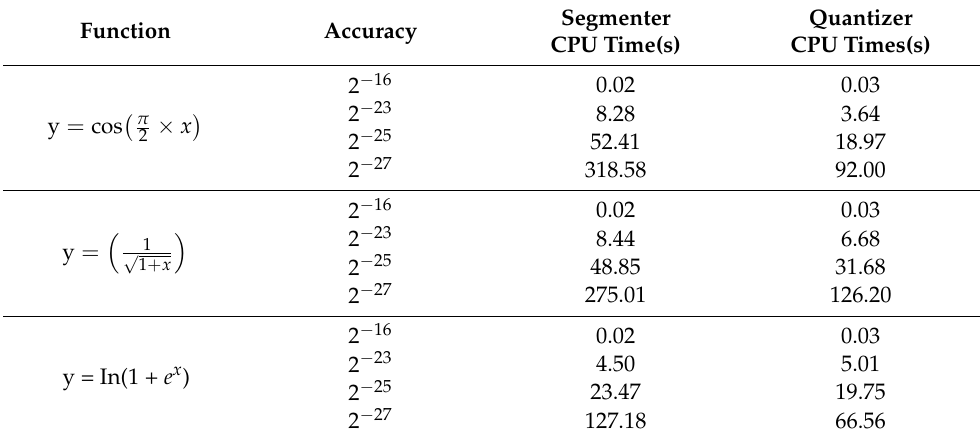
Table 3. Simulation time on